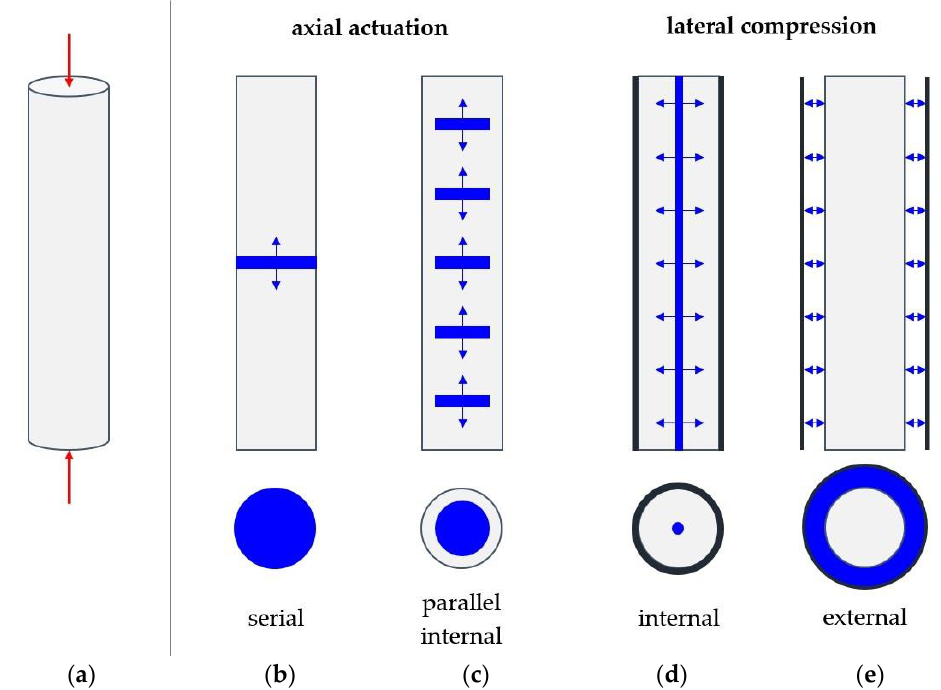
Figure 3. Concepts for adaptive concrete columns. ( a ) Central cylindrical passive concrete column as base; ( b ) serial axial actuation; ( c ) parallel internal axial actuation; ( d ) internal lateral compression actuation; ( e ) external lateral compression actuation.